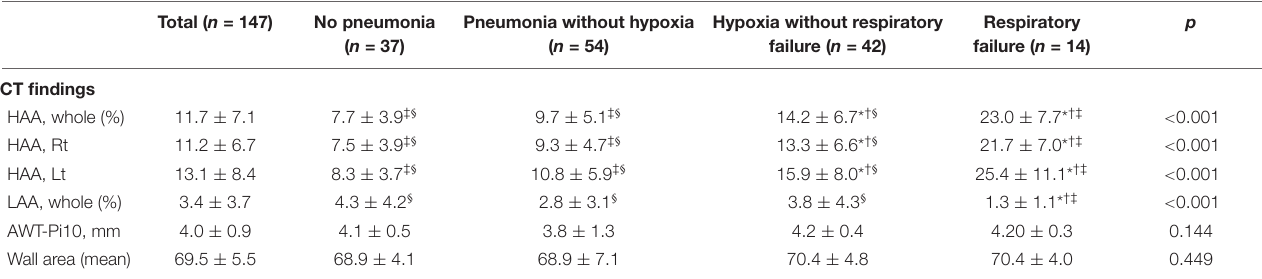
TABLE 2 | Quantitative CT findings according to the level of